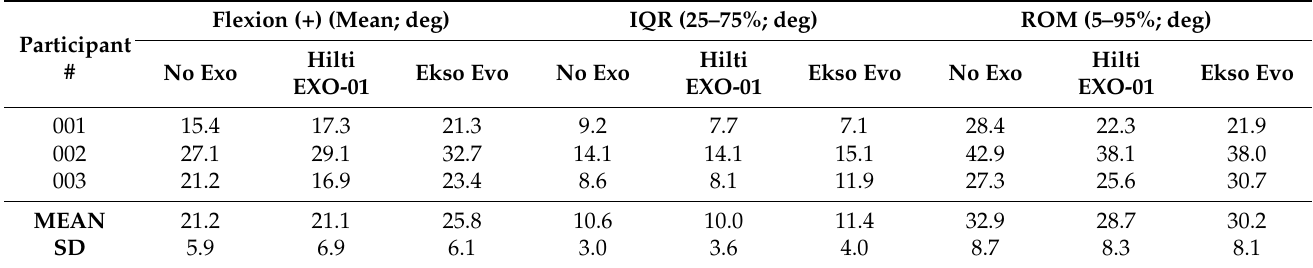
Table 8. Abduction/adduction (deg) of the right shoulder.